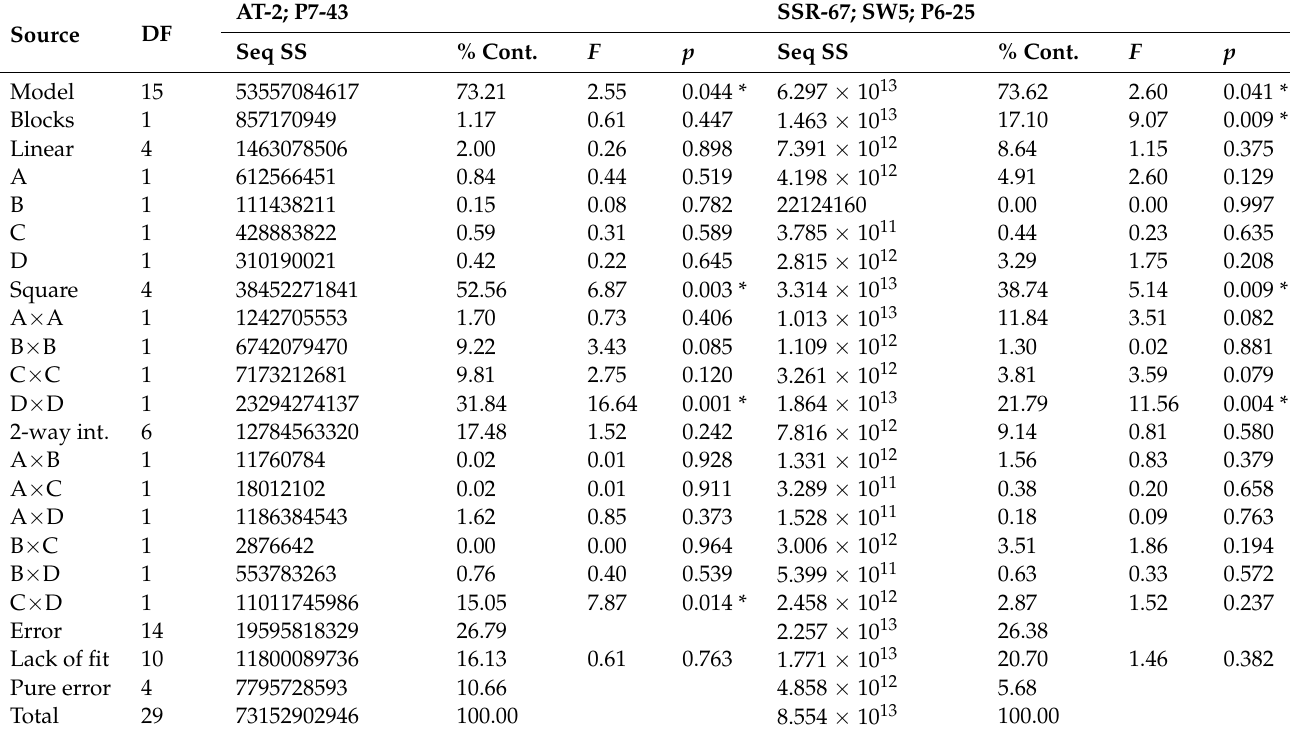
Figure 2. Statistically significant and not significant differences between concentrations of each factor and their interaction, normal plot of the standardized factors and interaction effects on the response variable (fluorescence intensity of the PCR products). ( A ) Multiplex PCR of At–2, and P7–43, molecular markers; ( B ) multiplex PCR of SSR–67, Sw–5 and P6–25 molecular markers. Table 4. Analysis of variance (ANOVA) for the fluorescence intensity values for molecular markers using RSM-CCD.